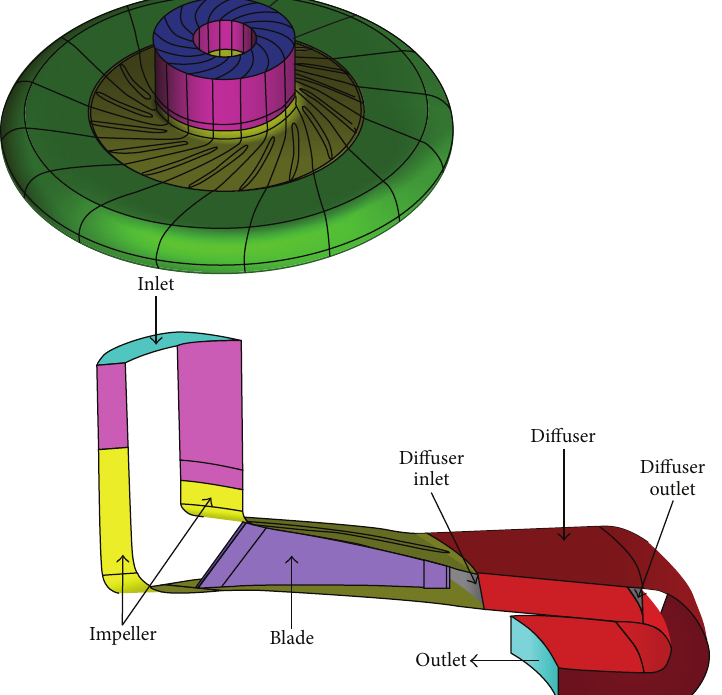
Figure 1: Geometry of the centrifugal compressor.